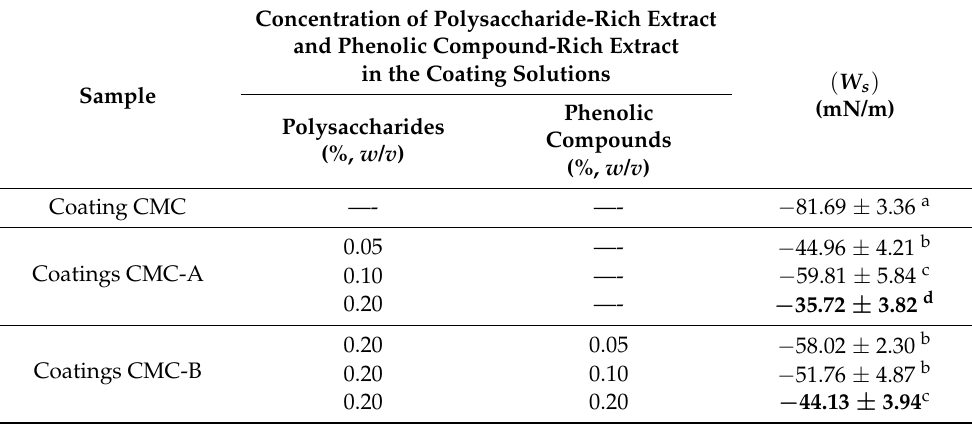
Table 1. Spreading coefficient ( W s ) of the CMC-based coating solutions tested on fresh goldenberry surface. Concentration of Polysaccharide-Rich Extract and Phenolic Compound-Rich Extract in the Coating Solutions ( W s ) Sample (mN/m) Phenolic Polysaccharides Compounds (%, w / v ) (%, w / v ) Coating CMC —- —- − 81.69 ± 3.36 a 0.05 Coatings CMC-A